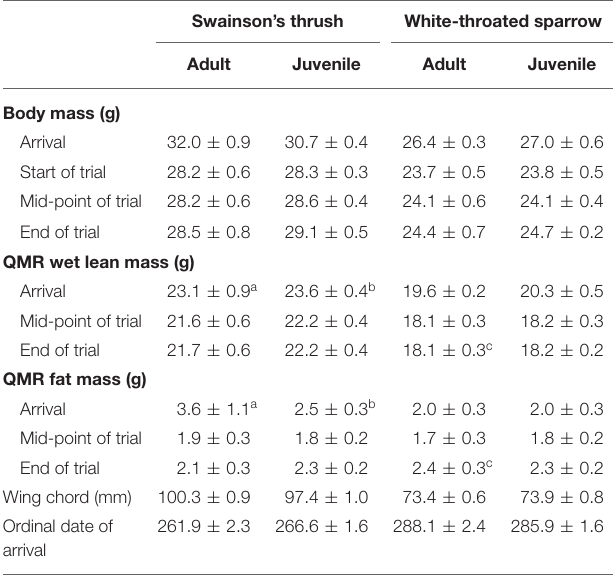
TABLE 3 | Body mass, body composition, wing chord, and arrival date for migrating adult and juvenile Swainson’s thrushes and white-throated